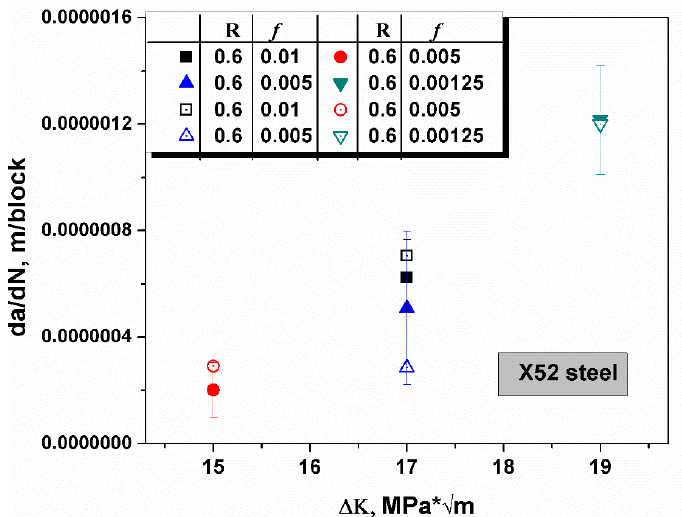
Figure 7. The schematic shows the comparison of the predicted crack growth rates (open symbols) and experimental values in X52 steel [42]. The R ratio and loading frequency f are recorded in the chart. The predictive values fit well with the experimental data at an n value of